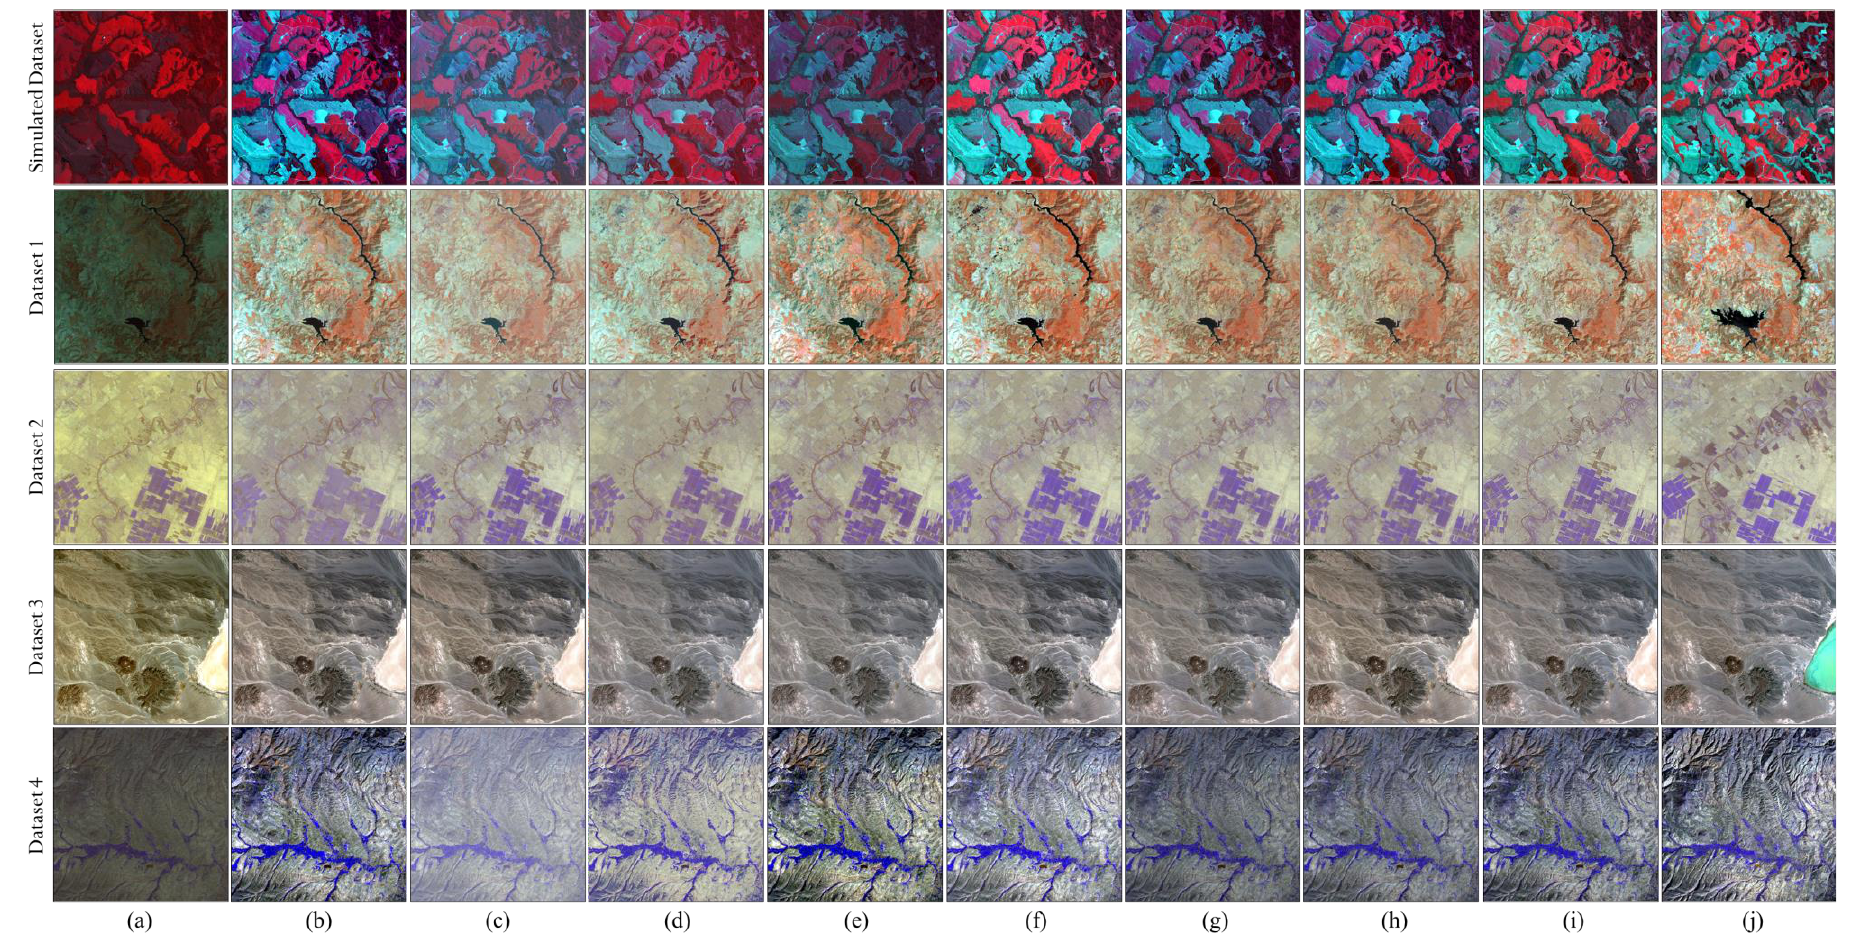
Figure 10. Visualizations of the RRN results over the simulated dataset and real datasets 1 to 4, obtained by the proposed method and other well-known SRRN models. ( a ) target images; and normalized images generated by ( b ) IRMAD [15], ( c ) multi-Otsu-based [29], ( d ) MPIF [22], ( e ) ASCR-RF-based [27], ( f ) GMM-EE [24], ( g ) HOG-based [31], ( h ) FLSM-based [3], ( i ) the proposed method, and ( j ) the reference images.